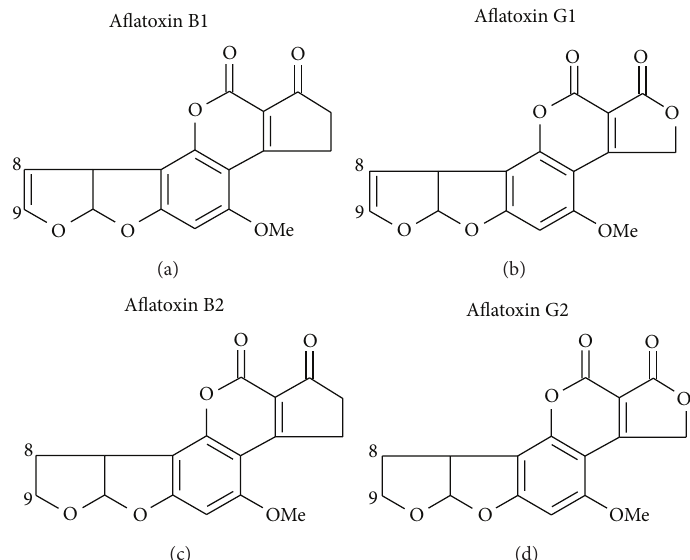
Figure 1: Structures of the major naturally occurring aflatoxins. Aflatoxin B1 dominates the natural occurrence and is the most toxic and